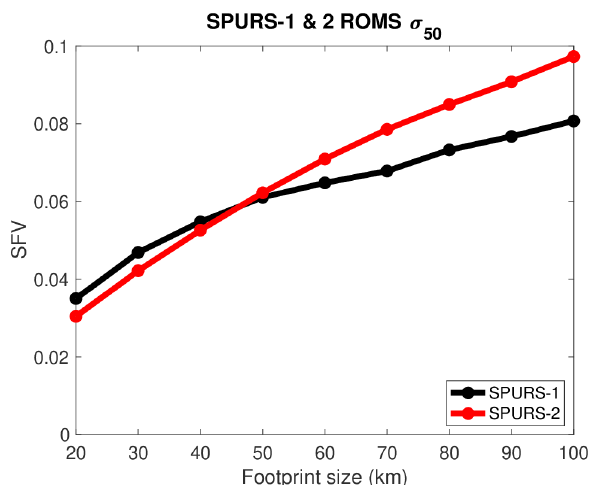
Figure 9. As in Figure 2, but for ROMS output.